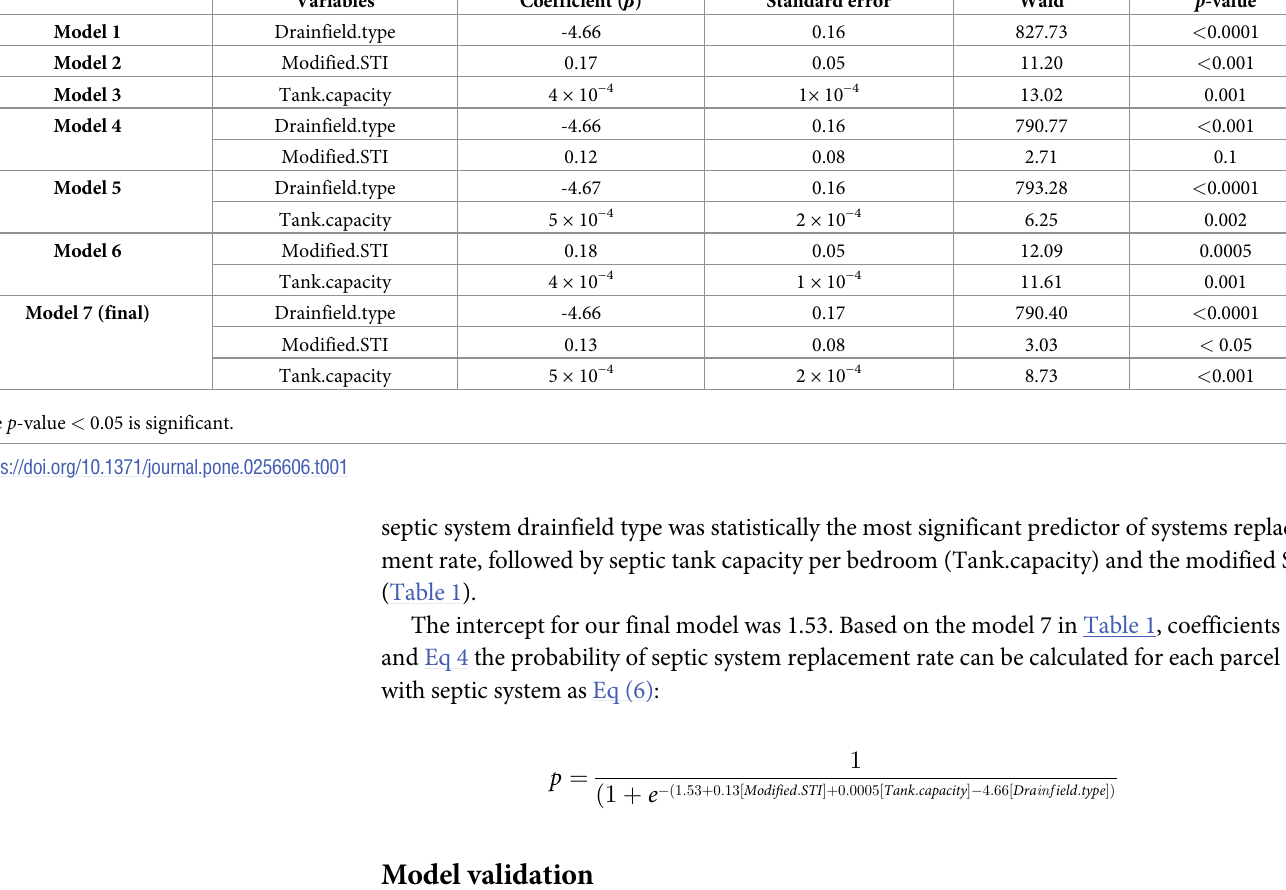
Table 1. The output of the logistic regression model for training dataset: Coefficients ( β n ), standard error, Wald statistics, and p -value.